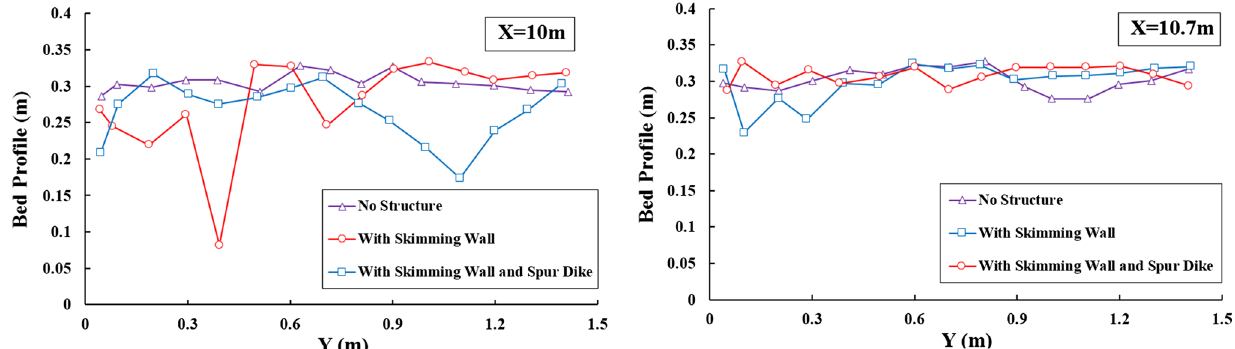
Fig. 10 Bed topography at the intake entrance with and without skimming wall and spur dike